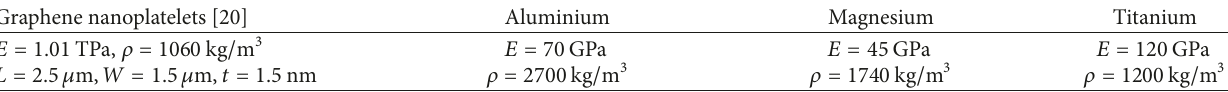
Table 1: Nanocomposite phases: material and geometrical properties.